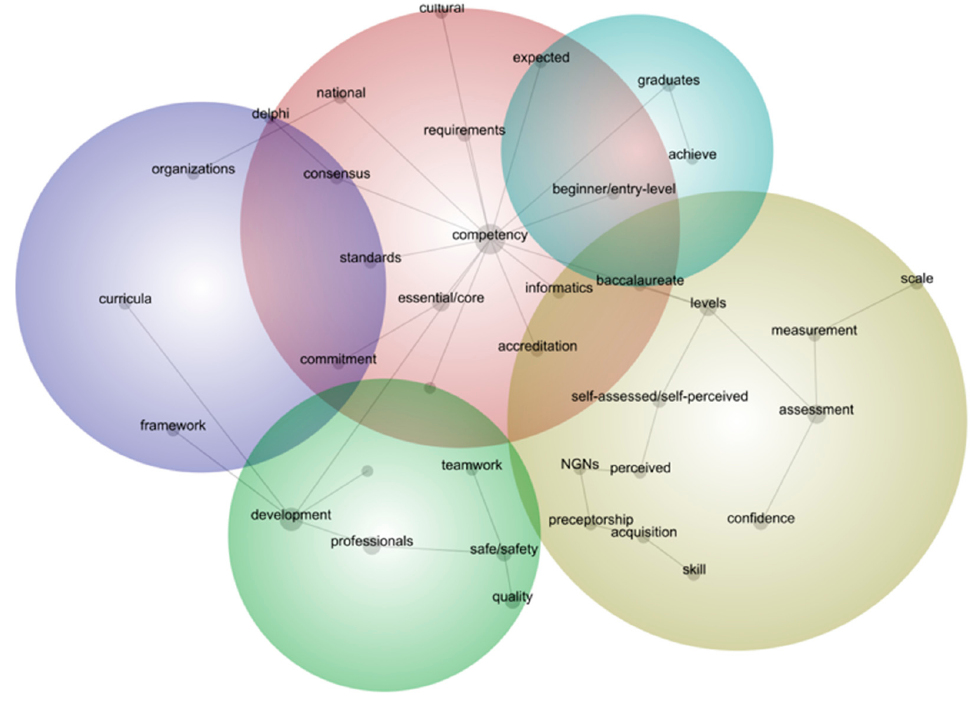
Figure 2. Concept map of ‘competence/competency’ profiling in the global literature.